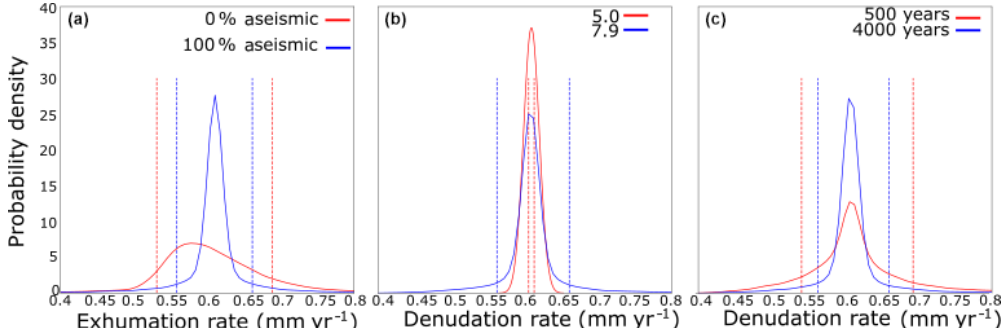
Figure 4. Kernel density plots (bandwidth of 0.01) of exhumation and denudation rates in various scenarios. Dashed lines indicate the position of the mean ± the standard deviation of the distribution. Each curve is made up of 10000 samples taken from their respective model runs. (a) Exhumation rates in different uplift regimes. (b) Denudation rates while varying the maximum earthquake magnitude in a run; the run with a maximum magnitude 5 has only earthquakes of a magnitude 5. (c) Denudation rates while varying the frequency of Wenchuan size earthquakes from every 500 to every 4000